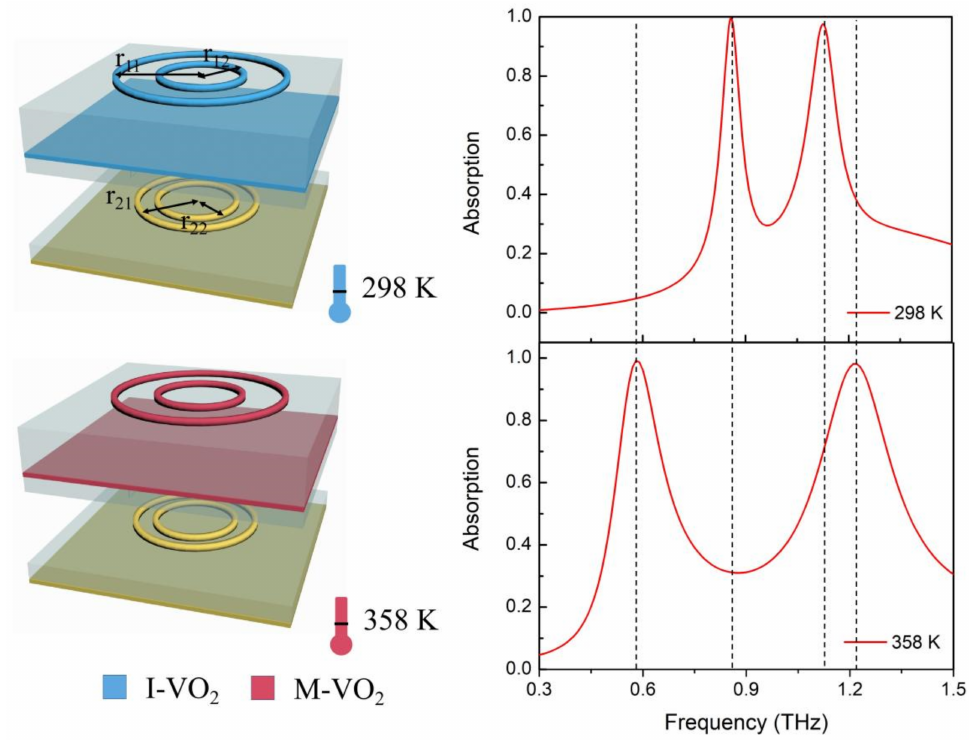
Figure 5. Schematic diagram and the absorption spectrum of the multi-band absorber at 298 K and 358 K. The parameters in the diagrams are r 11 = 40 µ m, r 12 = 25 µ m, r 21 = 28 µ m, r 22 = 22 µ m and the other geometric parameters of the structure are the same as those in Figure